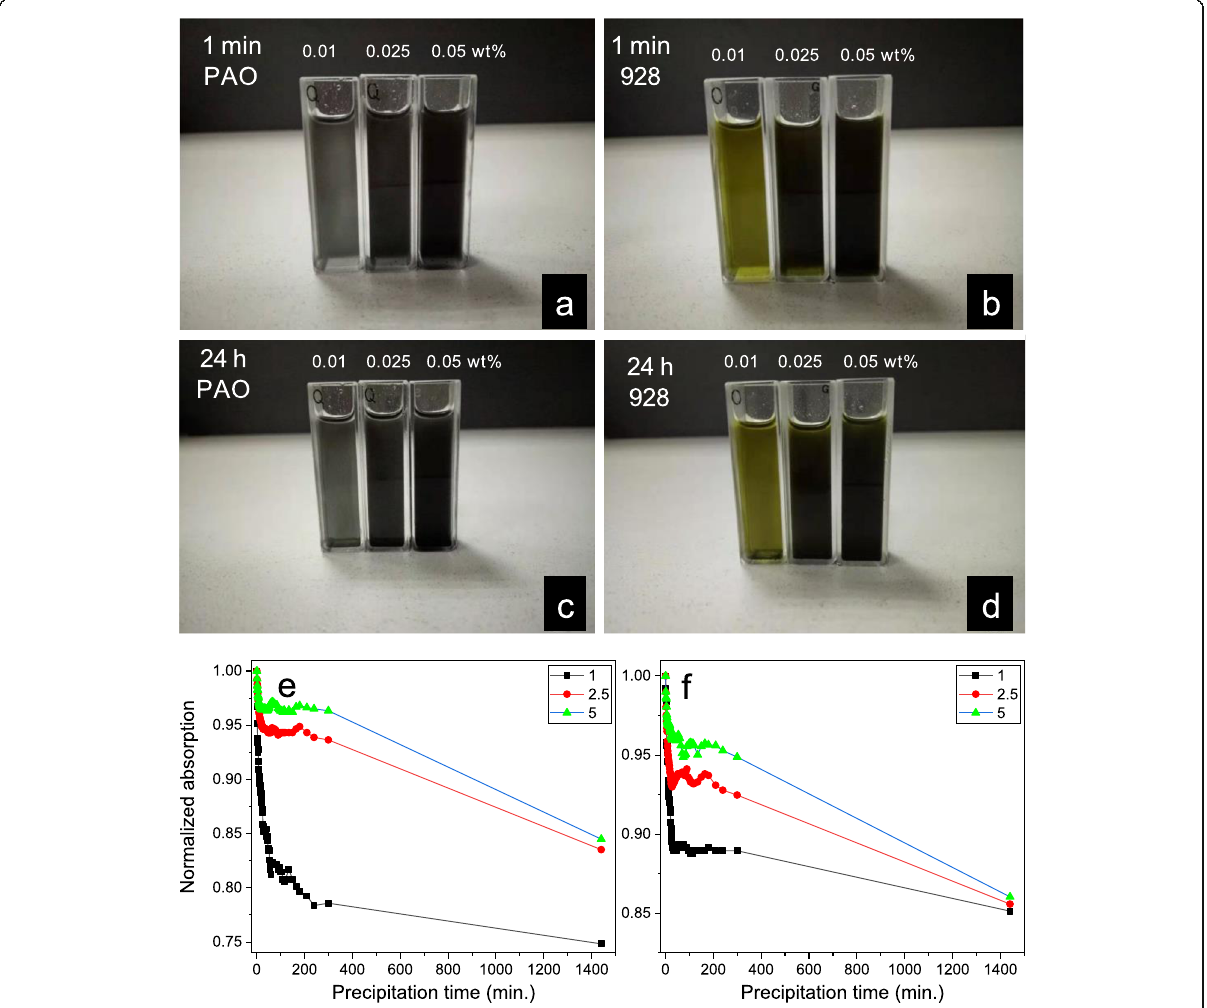
Fig. 7 The optical photographs of the SA-GO (which is prepared by the reactions of octadecylamine and the sulfur-doped graphene oxide; the oxidation time of the graphene oxide is 24 h) ultrasonically dispersed in the PAO4 base oil ( a ) and the 928 aviation lubrication oil ( b ) and the PAO4 ( c ) and 928 ( d ) oil sample stand still for 24 h, respectively; the normalized adsorption of the SA-GO in PAO4 ( e ) and 928 ( f ) oil samples ( a – d , examined by UV-vis spectrophotometer) with the concentration of SA-GO is 1, 2.5, and 5 × 10 − 4 wt% within 1440 min